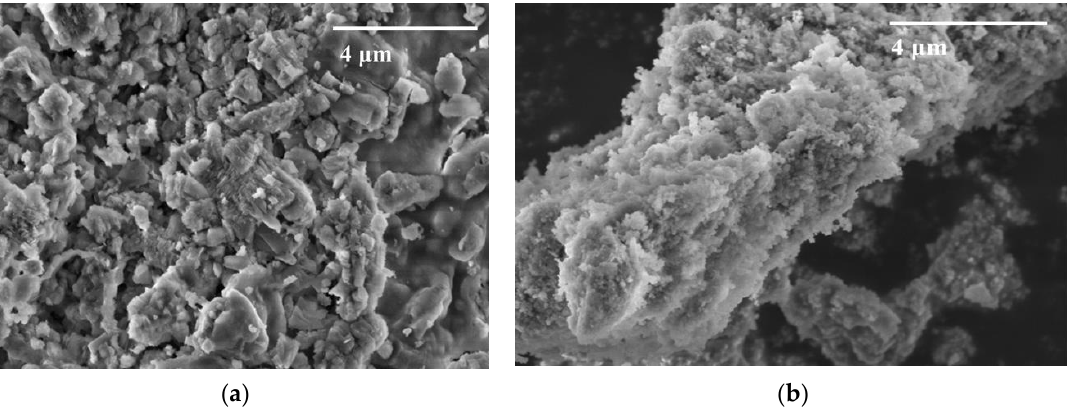
Figure 3. SEM image samples: ( a ) 10 wt% ZrO 2 -Al 2 O 3 -CeO 2 ; ( b ) 1 wt% ZrO 2 -Al 2 O 3 MgO-CeO 2 .